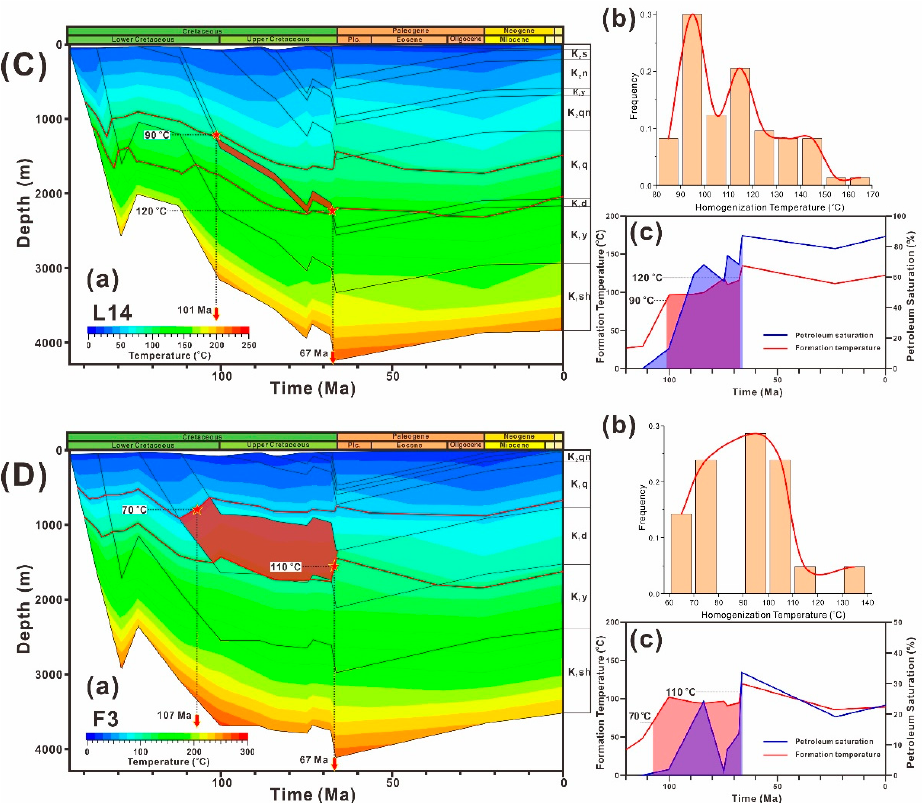
Figure 18. Petroleum-charging moment analysis for four key wells that represent the gas fields: Well CS1 ( A ), Well TS1 ( B ), Well L4 ( C ) and Well F3 ( D ). ( a ) Hydrocarbon-charging period according to the homogenization temperatures of fluid inclusions and the burial history curve. ( b ) Histogram of the homogenization temperatures of the fluid inclusions from Meng, 2009 [95]. ( c ) Petroleum saturation and formation-temperature trend of K 1 d, which were used to distinguish the charging